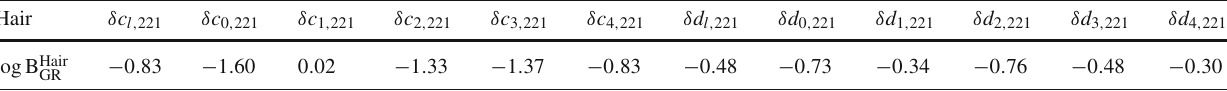
Table 1 Summary of the log Bayes factors for one possible hair versus GR